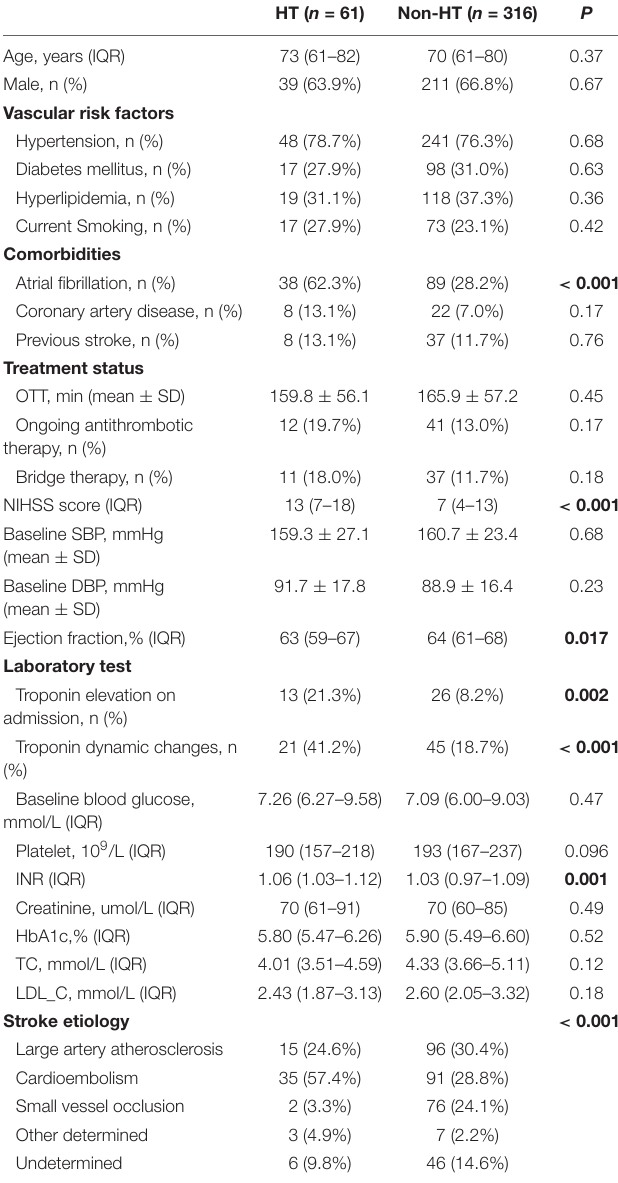
TABLE 2 | Clinical characteristics of patients, stratified by the presence of